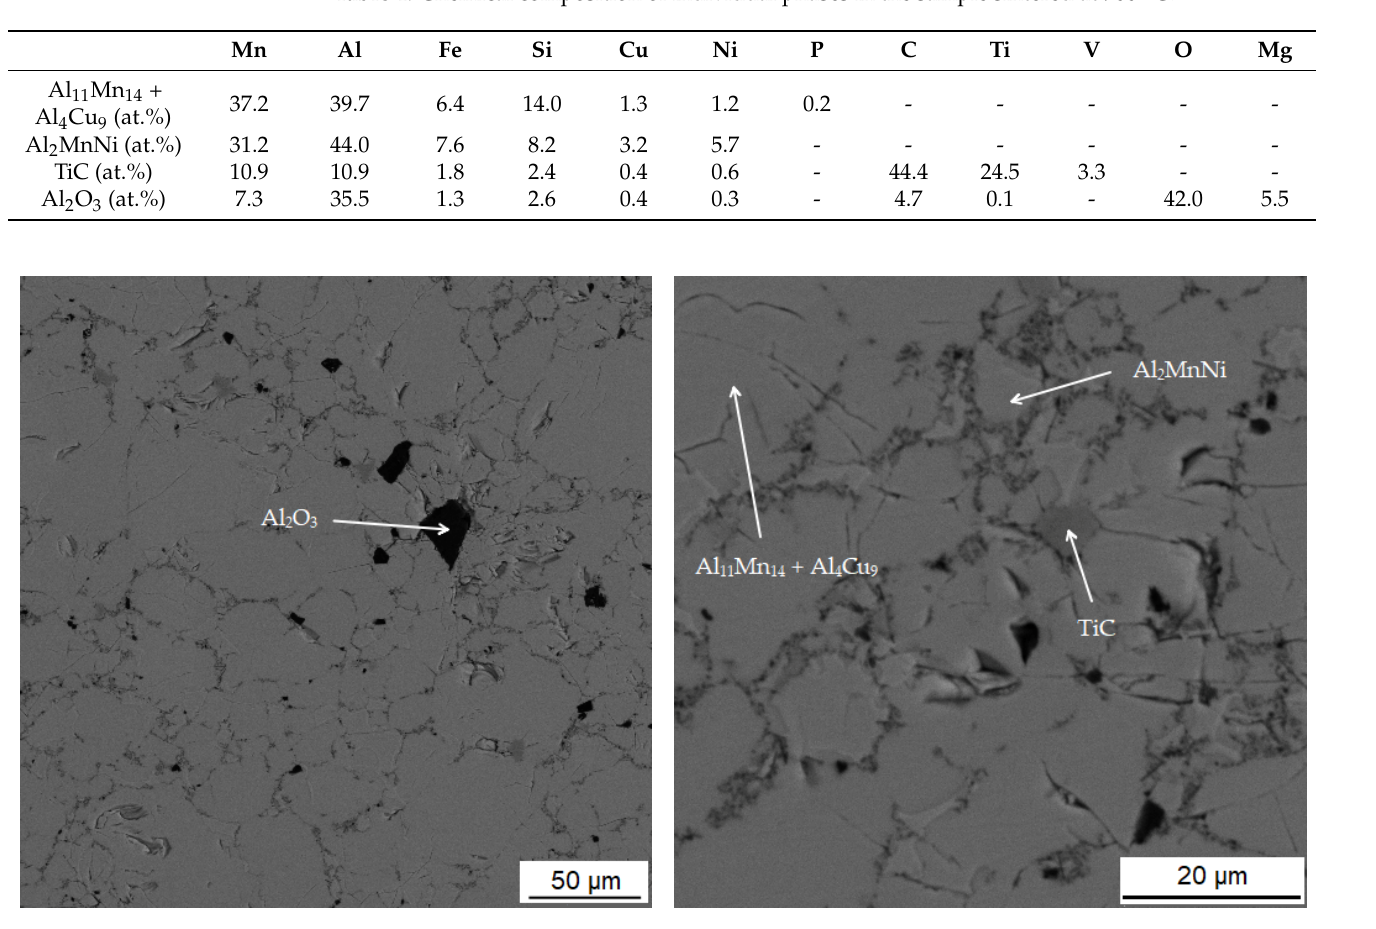
Figure 8. Microstructure of sample with 100% excess of aluminum over stoichiometry sintered at 900 °C.